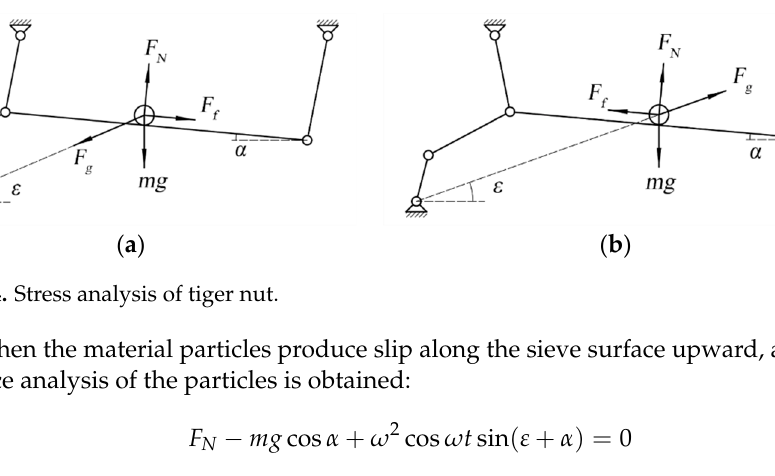
Figure 3. Schematic of the working principle. 1. Soil particles; 2. Tiger nut particles; 3. Stalk; 4.